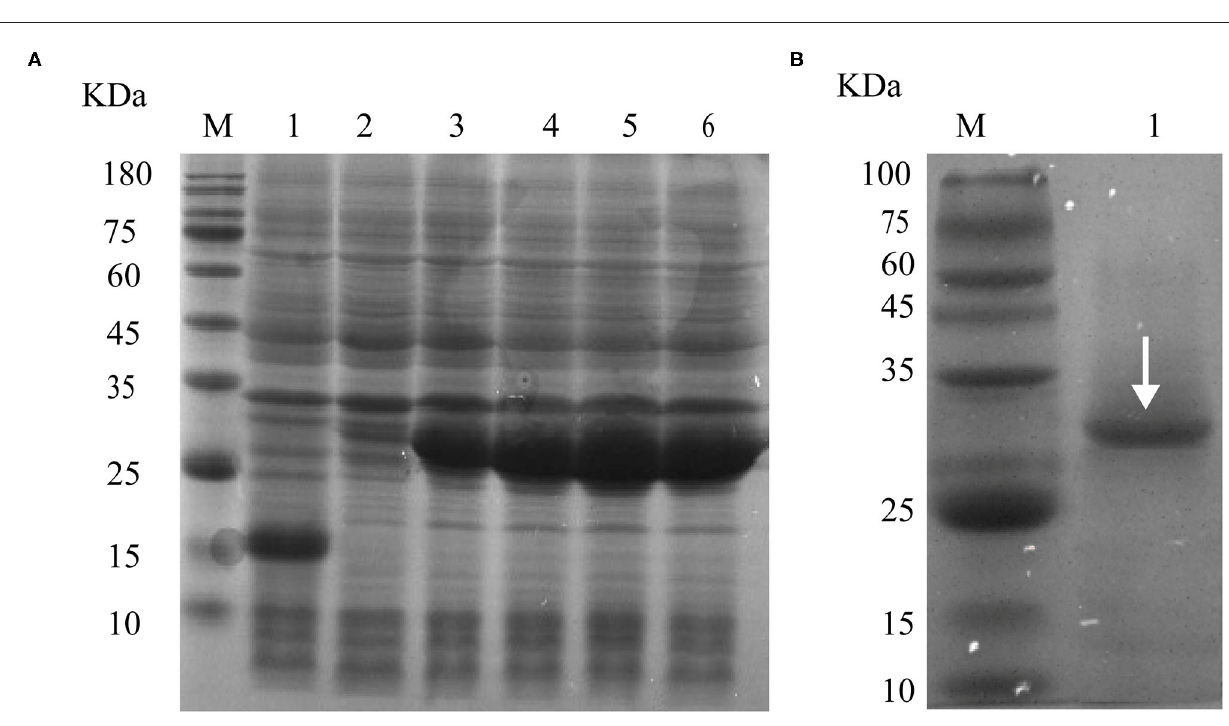
FIGURE 4 | rEg-TSP11 expression and purification. (A) Lane M: Protein molecular weight markers; Lane 1, The recombinant plasmid was transferred into E. coli BL21 (DE3) followed by IPTG induction of pET-32a ( + ) empty vector for 6h. Lane 2–6: Recombinant plasmids were transferred into E. coli BL21 (DE3) followed by IPTG induction of pET32a-TSP11 for 0, 2, 4, 6, and 8h. (B) Lane M: Protein molecular weight markers. Lane 1: protein sample following purification of the His-tagged rTSP11 protein using an Ni 2 +